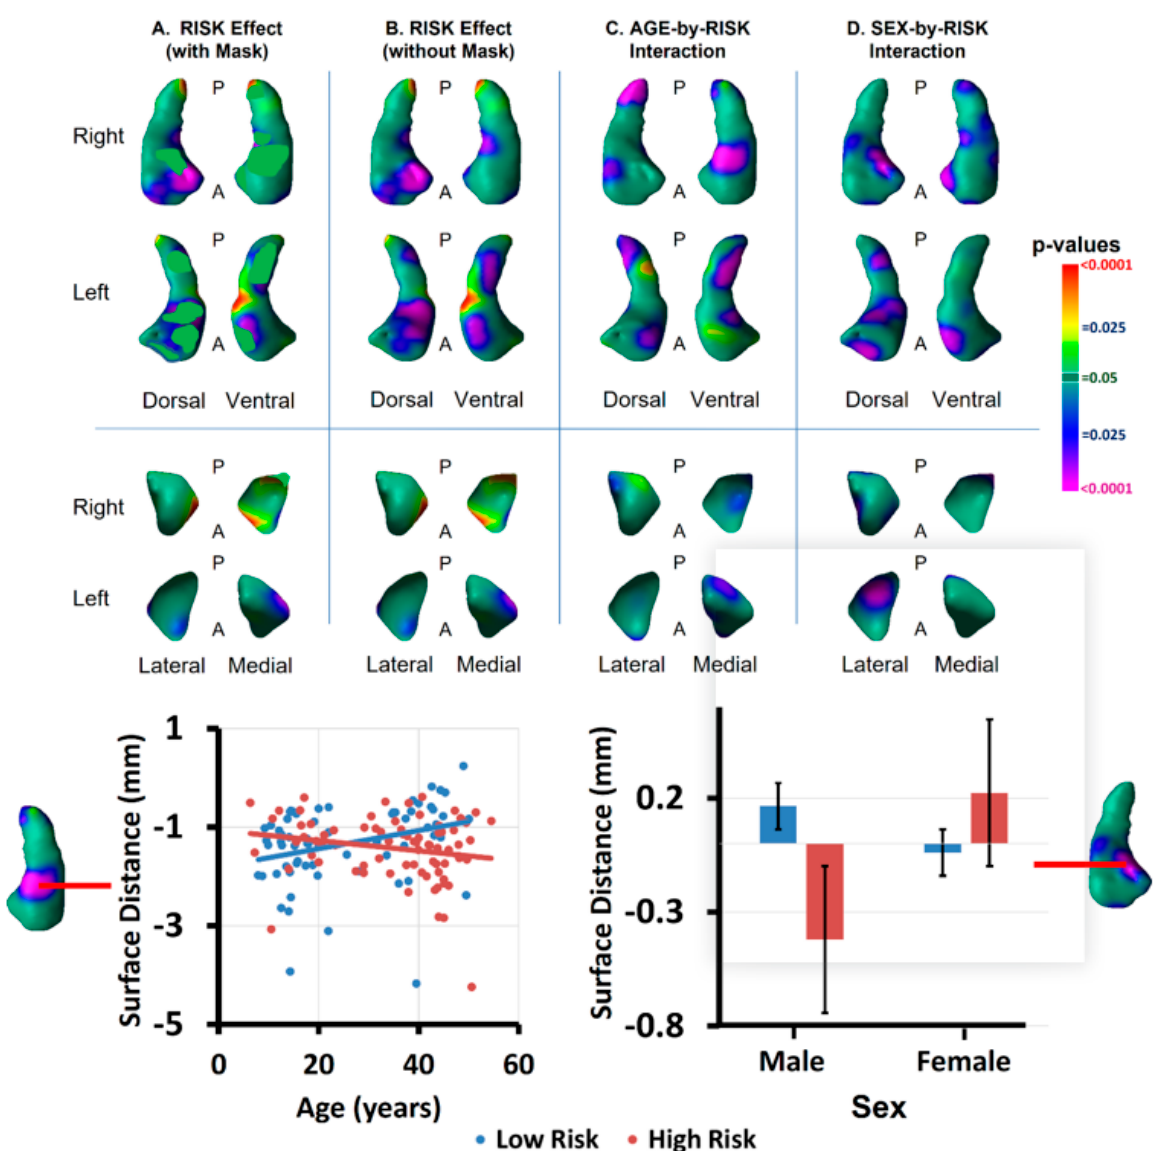
Figure 6. Interactions of Risk Group with Age and Sex, and Residual Risk Effects. Panel ( A ): The effect of risk group is shown only in locations without significant age- or sex-by-risk-group interactions, which have been masked out of the statistical map. The significant main effects of risk group that remain are, therefore, independent of age and sex and are valid for all ages and both sexes. The independent variables were age, age 2 , sex, and risk group. Panel ( B ): The effect of risk group is shown without masking any interaction effects (as shown in Figure 2). The independent variables were age, age 2 , sex, and risk group. Panel ( C ): The effect of the age-by-risk-group interaction is shown at each voxel. Significant voxels were used to generate a mask that was then applied to the statistical map of Panel ( A ). Independent variables were age, age 2 , sex, risk group, and age-by-risk-group. The scatterplot at the bottom left indicates that the interaction derives from increasing protrusion with age in the LR group but greater indentations with age in the HR group. Panel ( D ): The effect of the sex-by-risk-group interaction is shown at each voxel. Significant voxels were used to generate a mask that was then applied to the statistical map of Panel ( A ). Independent variables were age, age 2 , sex, risk group, and sex-by-risk-group. The bar graph on the bottom right indicates that the interaction derives from greater indentations in the HR males than in the other